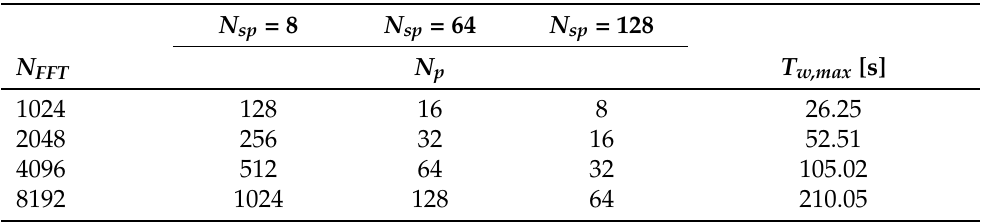
Table 6. Number of periods N p and maximum time window T w , max for different N FFT and N sp with F ADC , min .